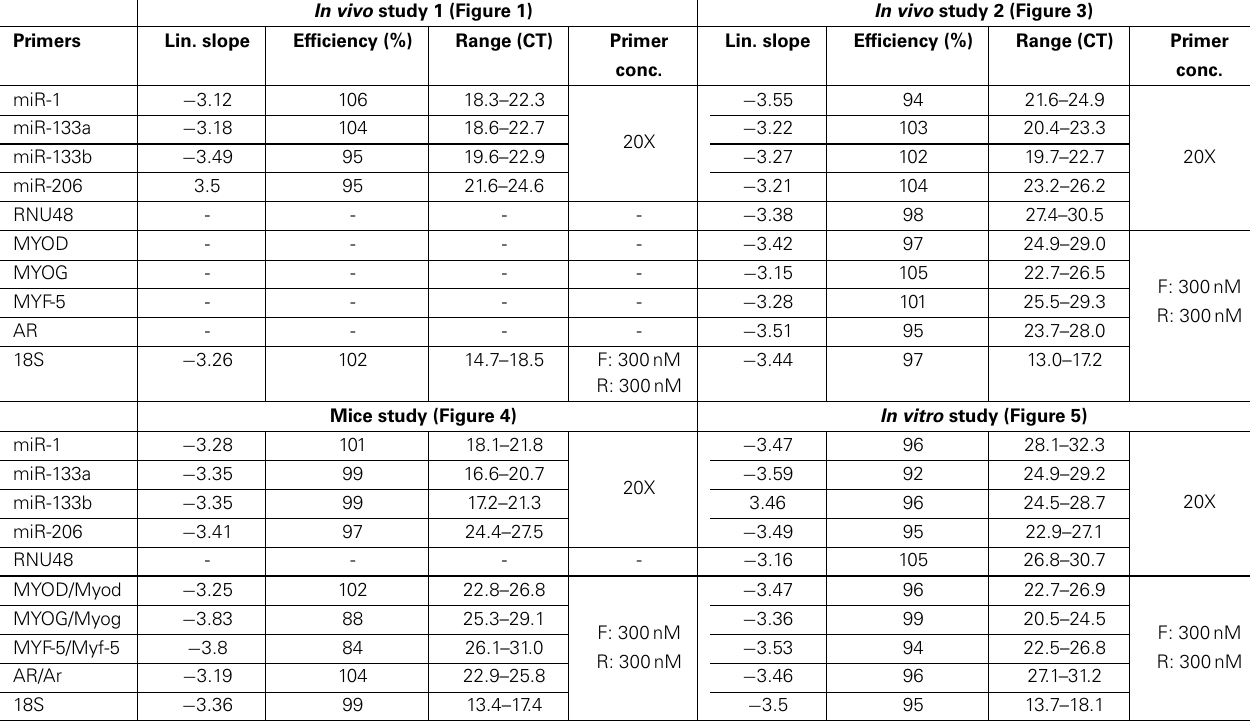
Table 3 | PCR standard curve